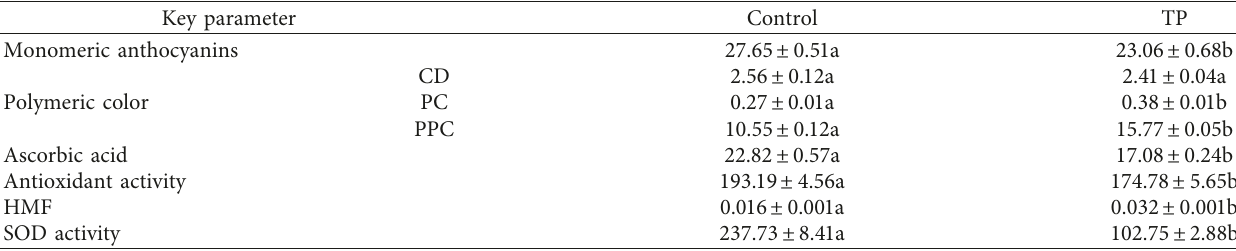
Table 2: Effects of TP treatment on the quality of bayberry juice.